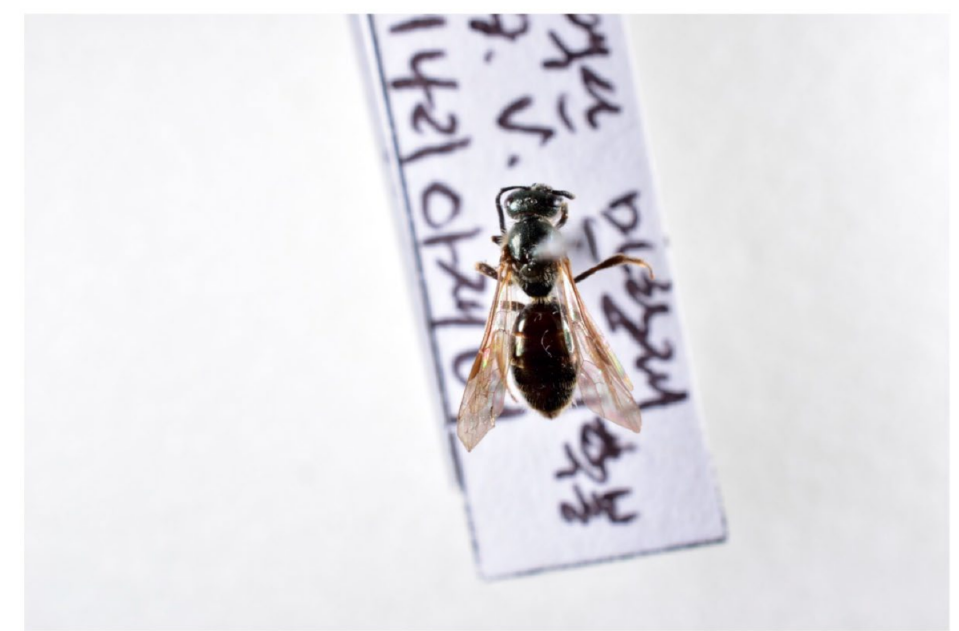
Figure 2. The effective pollinator ( Lasioglossum virideglaucum ) of Cypripedium guttatum at the Man- hangjae site in the Republic of Korea. The photograph was taken by H.-S.L., and the specimen was deposited in the Plant Quarantine Technology Center in the Republic of Korea.